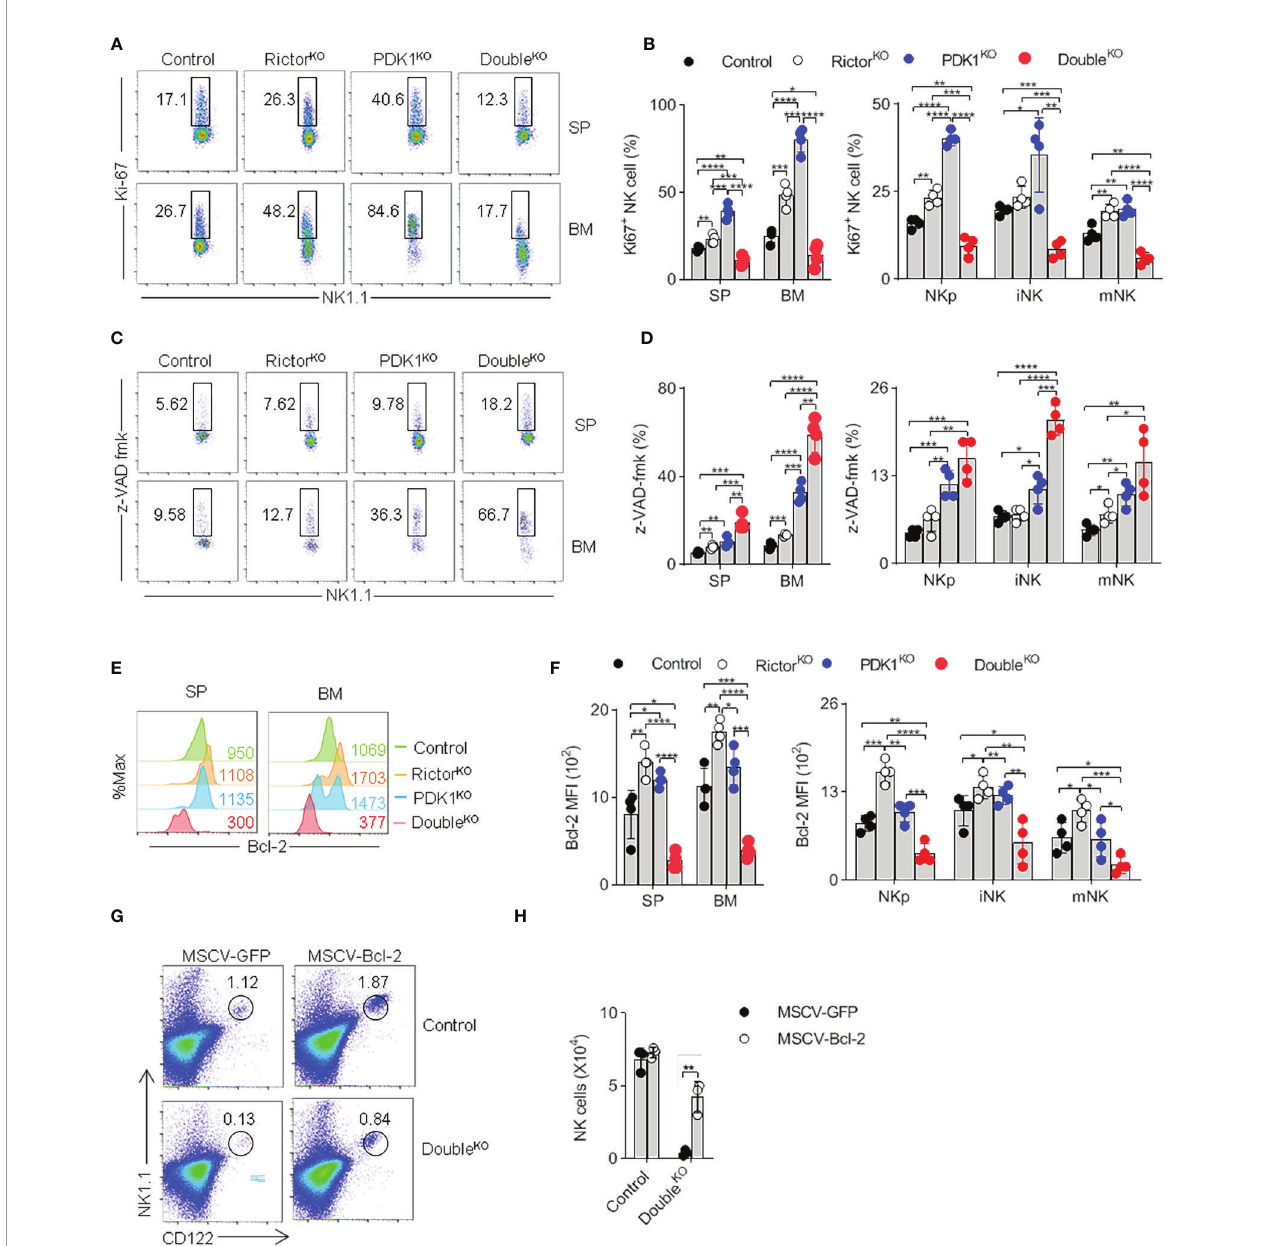
FIGURE 7 | Reduced PKB activation promotes NK cell apoptosis. (A, B) Representative fl owcytometric plots (A) and the percentage (B) of total and stage-speci fi c Ki67 + NK cells in the SP and BM of indicated mice. (C, D) Representative fl ow cytometric plots (C) and the proportion (D) of total and stage-speci fi c caspase- positive NK cell in the SP and BM of indicated mice. (E, F) Representative overlaid histograms (E) and the absolute MFI (F) demonstrate the expression levels of Bcl- 2 in total and stage-speci fi c NK cells in the spleen and bone marrow of indicated-mice. (G, H) Representative fl ow cytometric results (G) and the statistics (H) indicate the effect of Bcl-2 on the proportion of NK cell after supplement Bcl-2 to the PDK1/Rictor-de fi cient mice. The data represent one of three independent experiments, n ≥ 3 for each experiment, and values are expressed as the mean ± SD. *p < 0.05, **p < 0.01, ***p < 0.001, ****p <